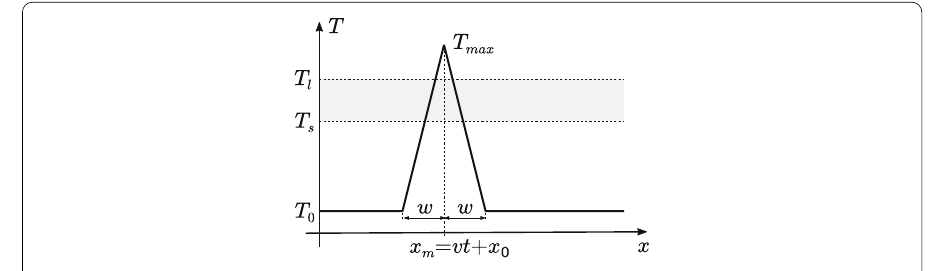
One-dimensional domain: inhomogeneous temperature